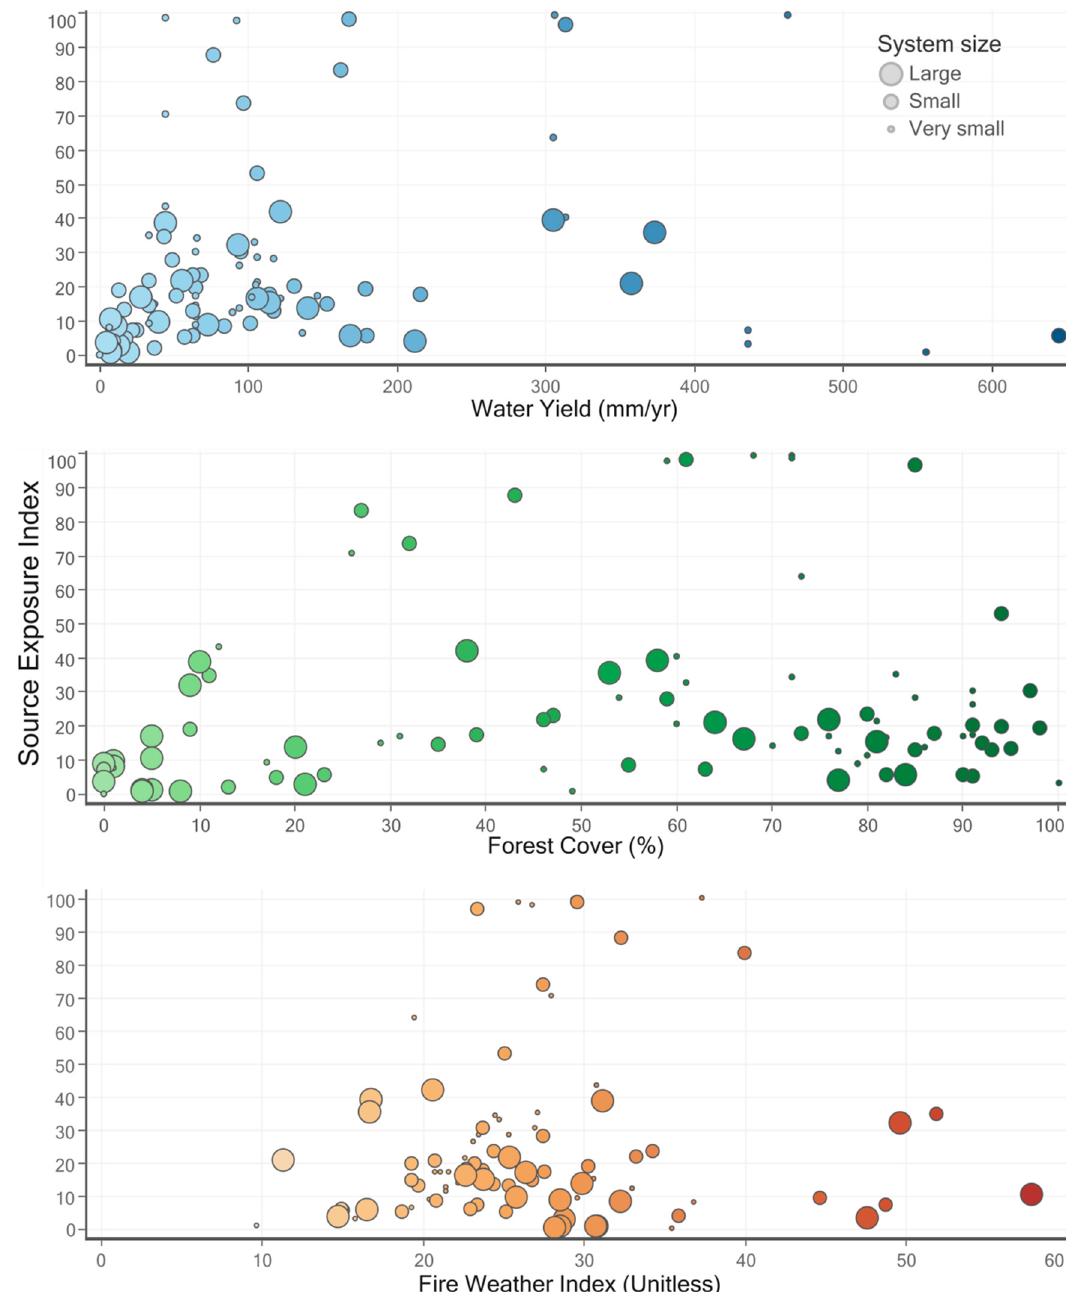
Figure 6. Scatterplots showing the relationship between the SEI score per source watershed and the three variables used to compute the index, namely the water yield, the forest cover, and the Fire Weather Index. The size of the dots are scaled by number of consumers served per drinking-water treatment plant, with very small, small, and large systems serving less than 500, 500 to 5000, and more than 5000 people, respectively. The shade of the dots helps to visualize change in the values of the different variables, darker tones showing greater values than lighter tones.